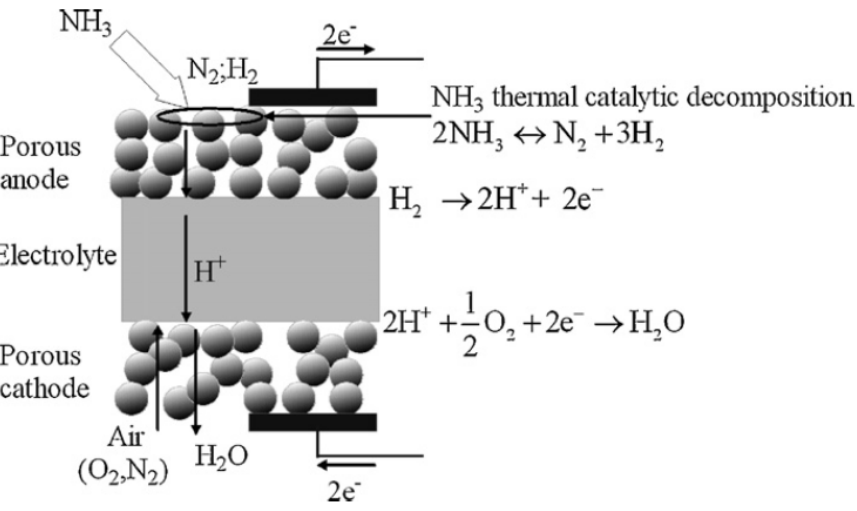
Figure 12. Working principle of SOFC − H with NH 3 as fuel [45].